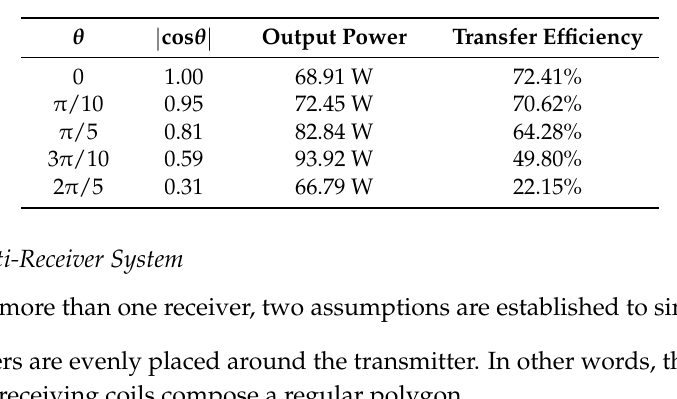
Figure 3. Transfer efficiency against time with different deviation angle. Table 1. Steady state solutions for single-receiver system.